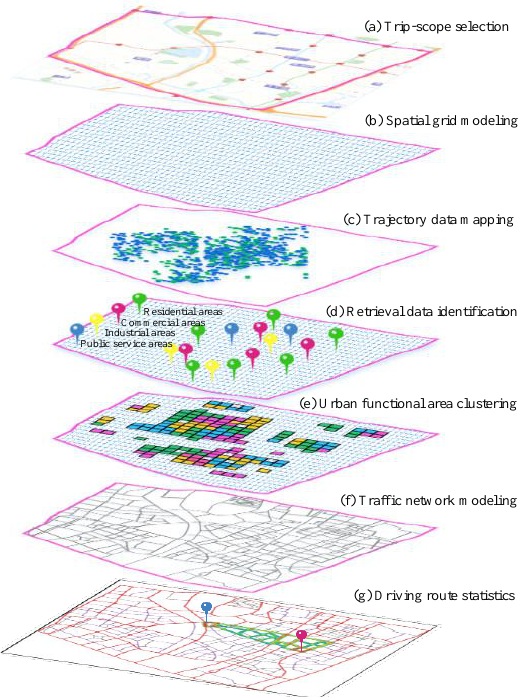
Figure 3. Architecture of data mining and fusion.